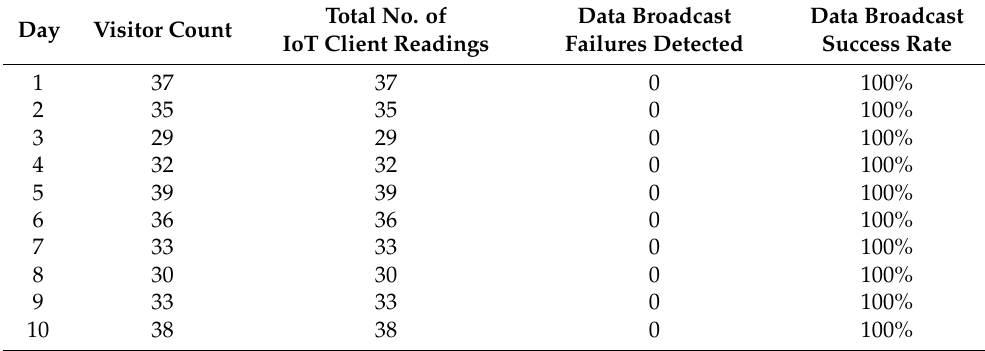
Table 3. Evaluation of IoT client